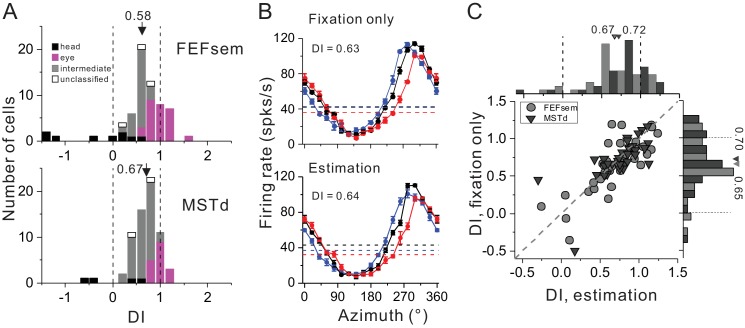
Spatial reference frame of cortical neurons during heading estimation task.(A) DI distributions post training of heading estimation task in FEFsem (upper panel: N = 65) and MSTd (bottom panel: N = 68). Black bars: head-centered coordinate; Magenta bars: eye-centered coordinate; Gray bars: intermediate coordinate; Open bars: unclassified coordinate. Arrowheads indicate mean values. Vertical dashed lines indicate head- (DI = 0) or eye-centered (DI = 1) coordinate. (B) Tuning functions of an example FEFsem neuron during the fixation only (post training) and active estimation conditions. (C) Comparison of DIs between fixation only and active estimation conditions on a cell by cell basis. Circle: FEFsem, N = 36; Triangle: MSTd, N = 35.10.7554/eLife.29809.018Figure 7—source data 1.Raw data for Figure 7A.